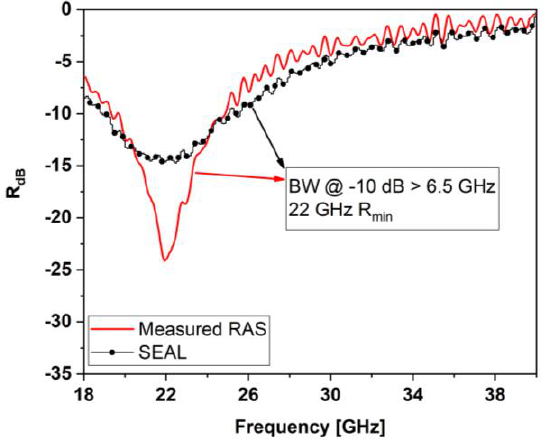
Figure 19. Comparison between the measured reflection coefficient of the SEAL (black line) and that of the RAS without sensors (red line).